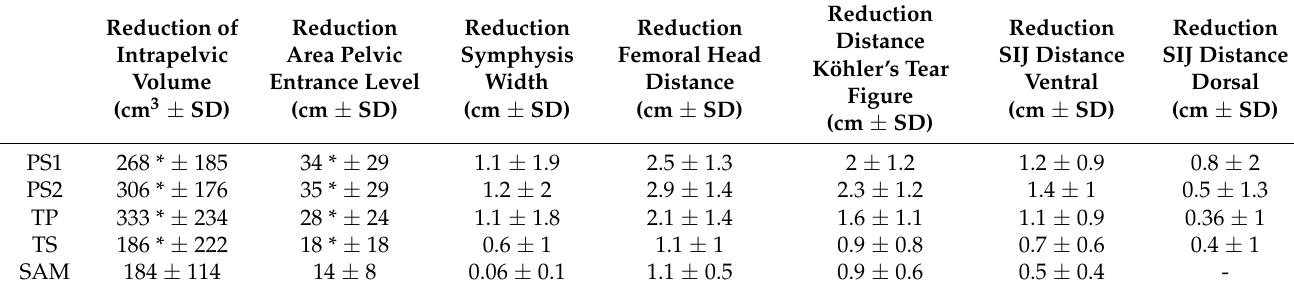
Table 1. Overview of the reduction results based on the mean values and standard deviation in direct comparison of the tested pelvic stabilizers to the native scans (PS1 = pneumatic pelvic sling VBM ® with applied pressure of 100 mmHg; PS2 = pneumatic pelvic sling VBM ® with applied pressure of 200 mmHg, TP = T-POD ® ; TS = cloth sling, SAM =